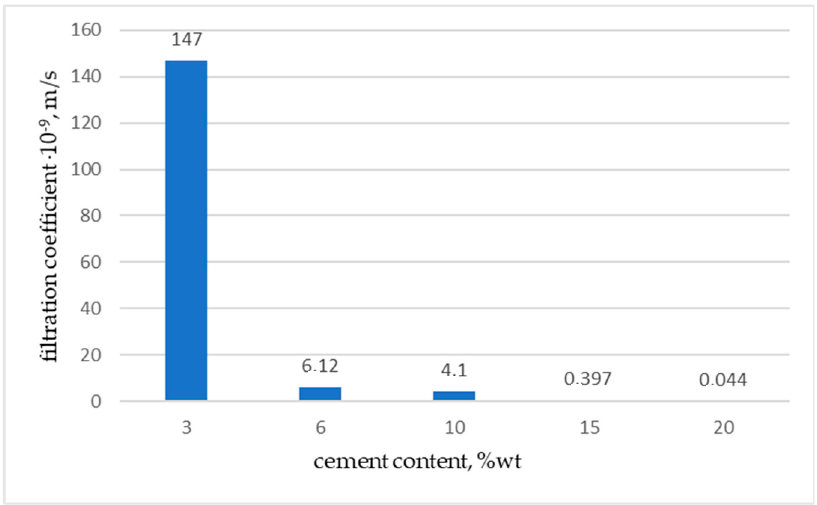
Figure 8. Effect of changing the amount of cement on the value of the filtration coefficient of binders.